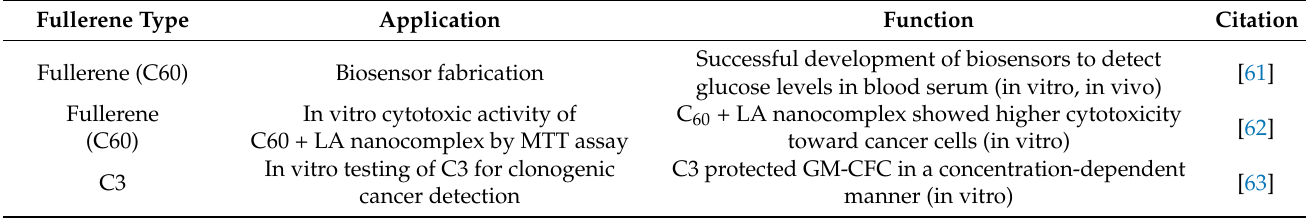
Table 7. Application of fullerene-based nanomaterials in cancer treatment.